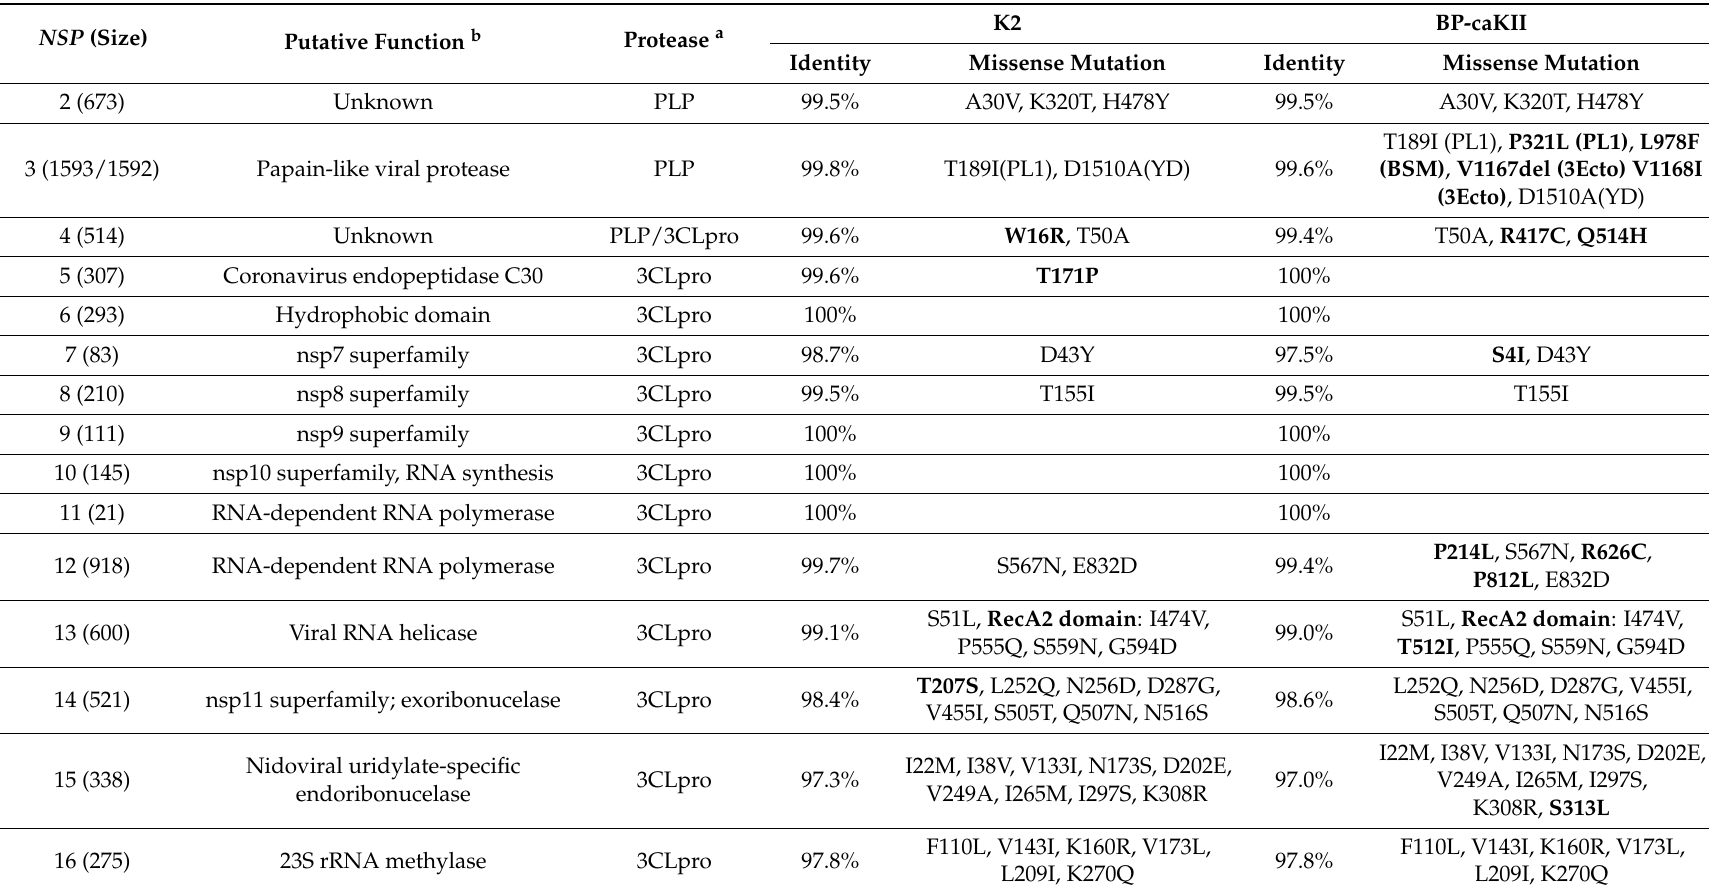
Table 6. Comparison of nonstructural proteins of KM91 with K2 and